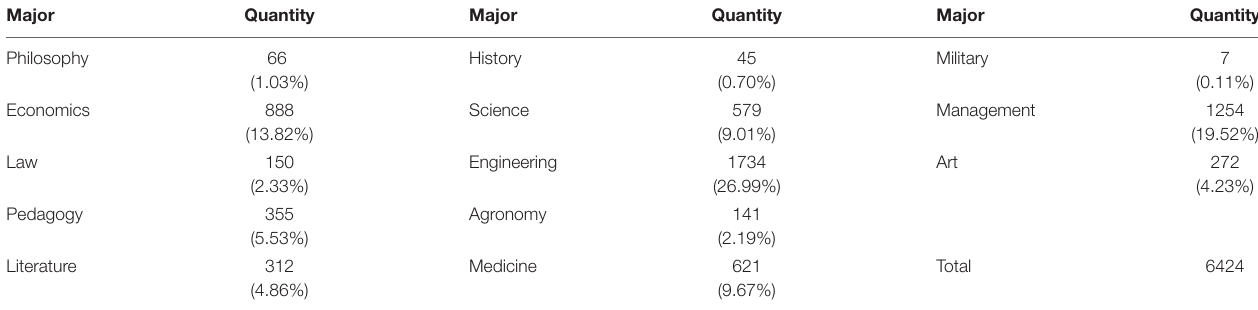
TABLE 1 | Distribution of majors.